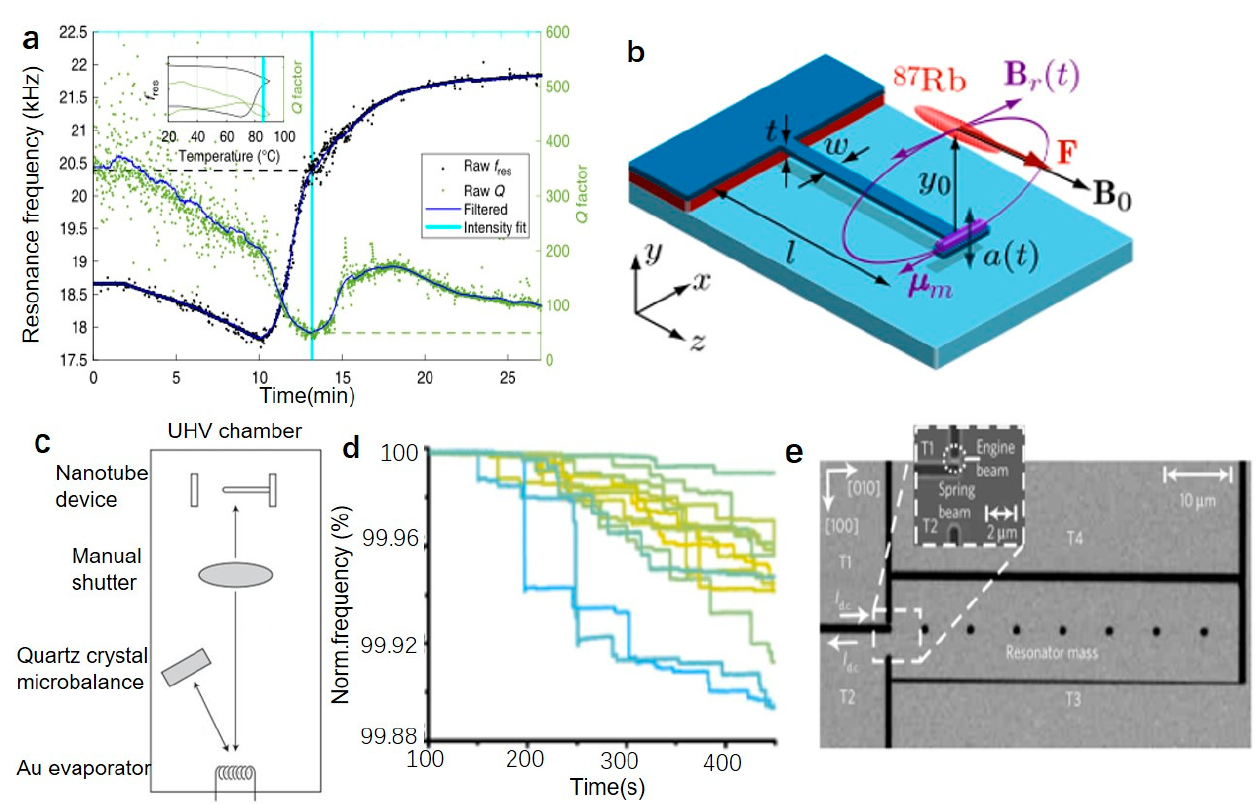
Figure 6. Single/double-clamped resonators as sensors. ( a ) Resonant frequency and quality factor of TP MH particle cantilever during thermal cycling. Adapted with permission from [67]. ( b ) Schematic diagram of BEC resonator. Magnetic coupling between atom and nanoresonator. Adapted with permission from [21]. ( c ) Nano-resonant mass spectrometry test system, Au atoms evaporate in the UVH cavity, manual shutter controls mass deposition and closing, QCM measures mass flow. Adapted with permission from [81]. ( d ) Frequency-time trace diagram obtained by 15 nanometer resonant arrays after 10 min of acquisition. Adapted with permission from [86]. ( e ) SEM image of the heat engine. The inset is an enlarged view of the engineering beam and spring beam. Adapted with permission from [91].